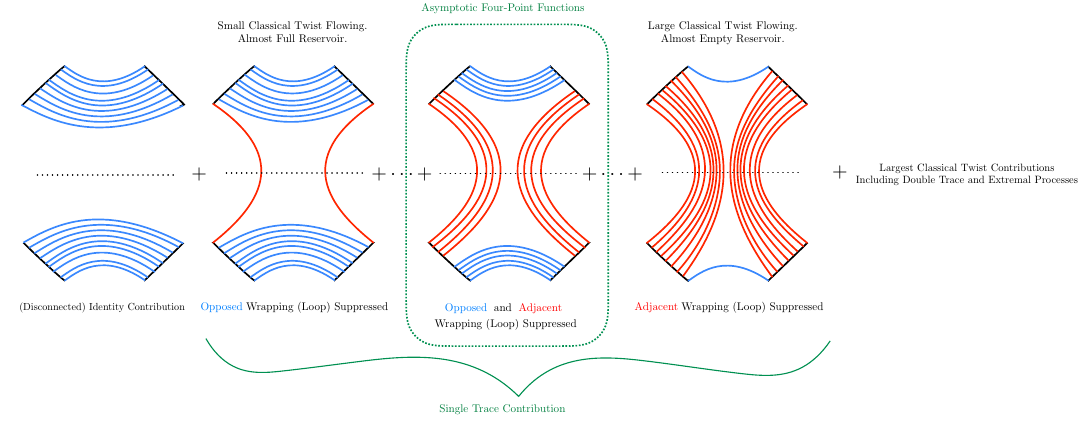
Figure 1. Various contributions to the 4pt